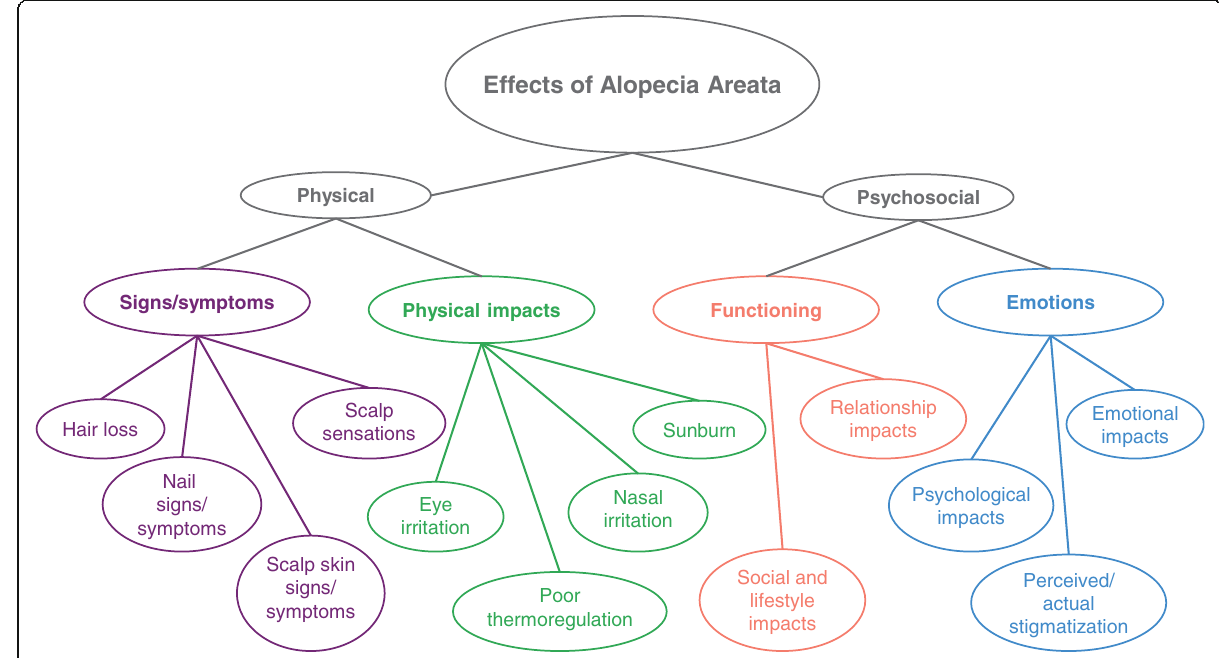
Fig. 1 Conceptual framework of the effects of alopecia